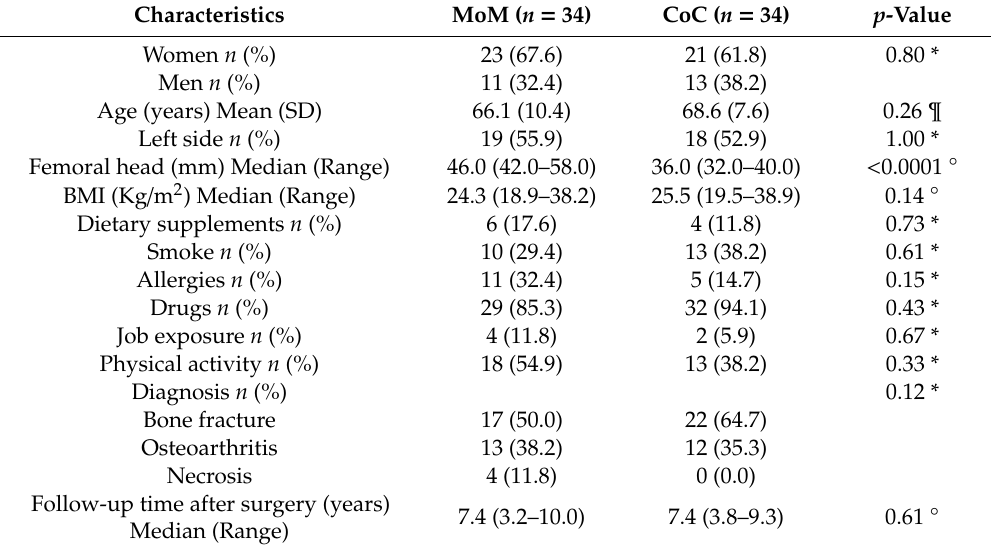
Table 1. Patients demographic and clinical